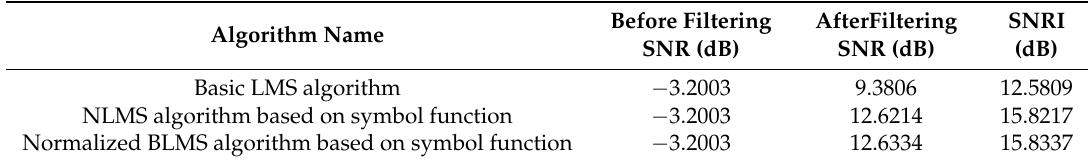
Table 4. SNR changes of MIT-BIH ECG signals before and after filtering with BW